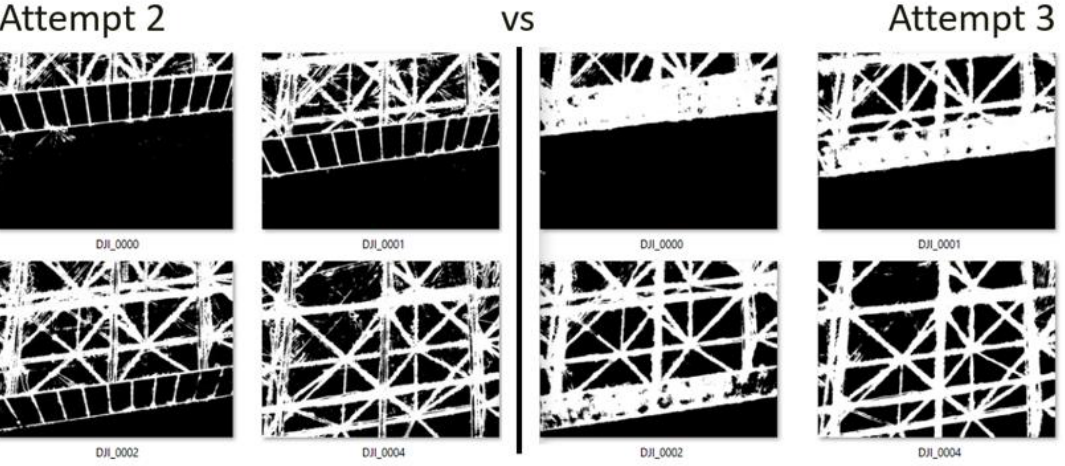
Figure 25. Changing the brightness and contrast of images from the UAV platform.